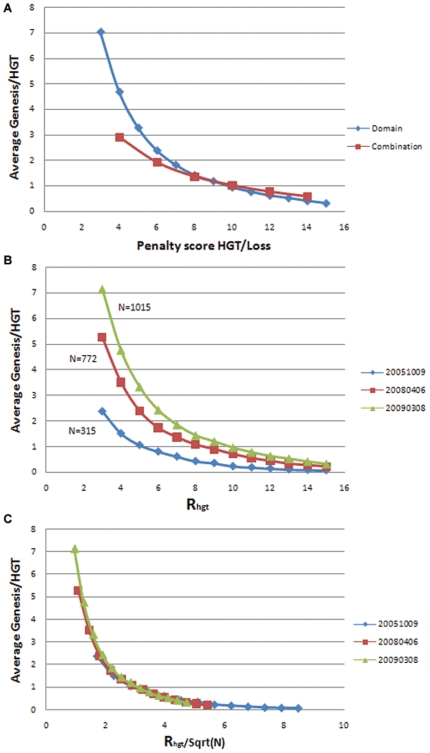
The predicted average HGT or independent genesis events.(A) The average number of HGT or independent genesis per domain/combination with respect to the relative penalty score of Genesis/HGT to loss varying from 3 to 15. (B) Comparison of average Genesis/HGT vs. Rhgt for three SUPERFAMILY releases: Oct 9th 2005, Aug 6th 2008 and Mar 8th 2009, containing 315, 772 and 1015 species respectively. (C) The same plot with the ratio normalized by an empirical factor. The new ratio is Rn = Rhgt/Sqrt(N), N is the total number of species in each release.